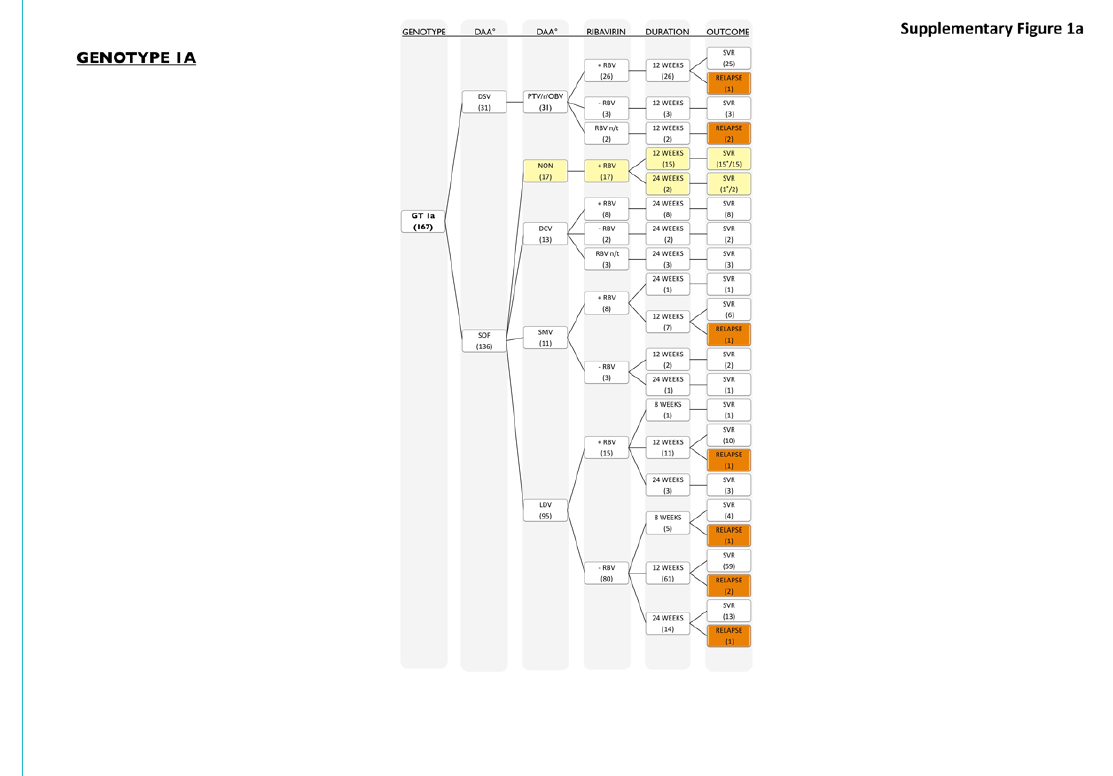
Figure S1a: Patients with genotype